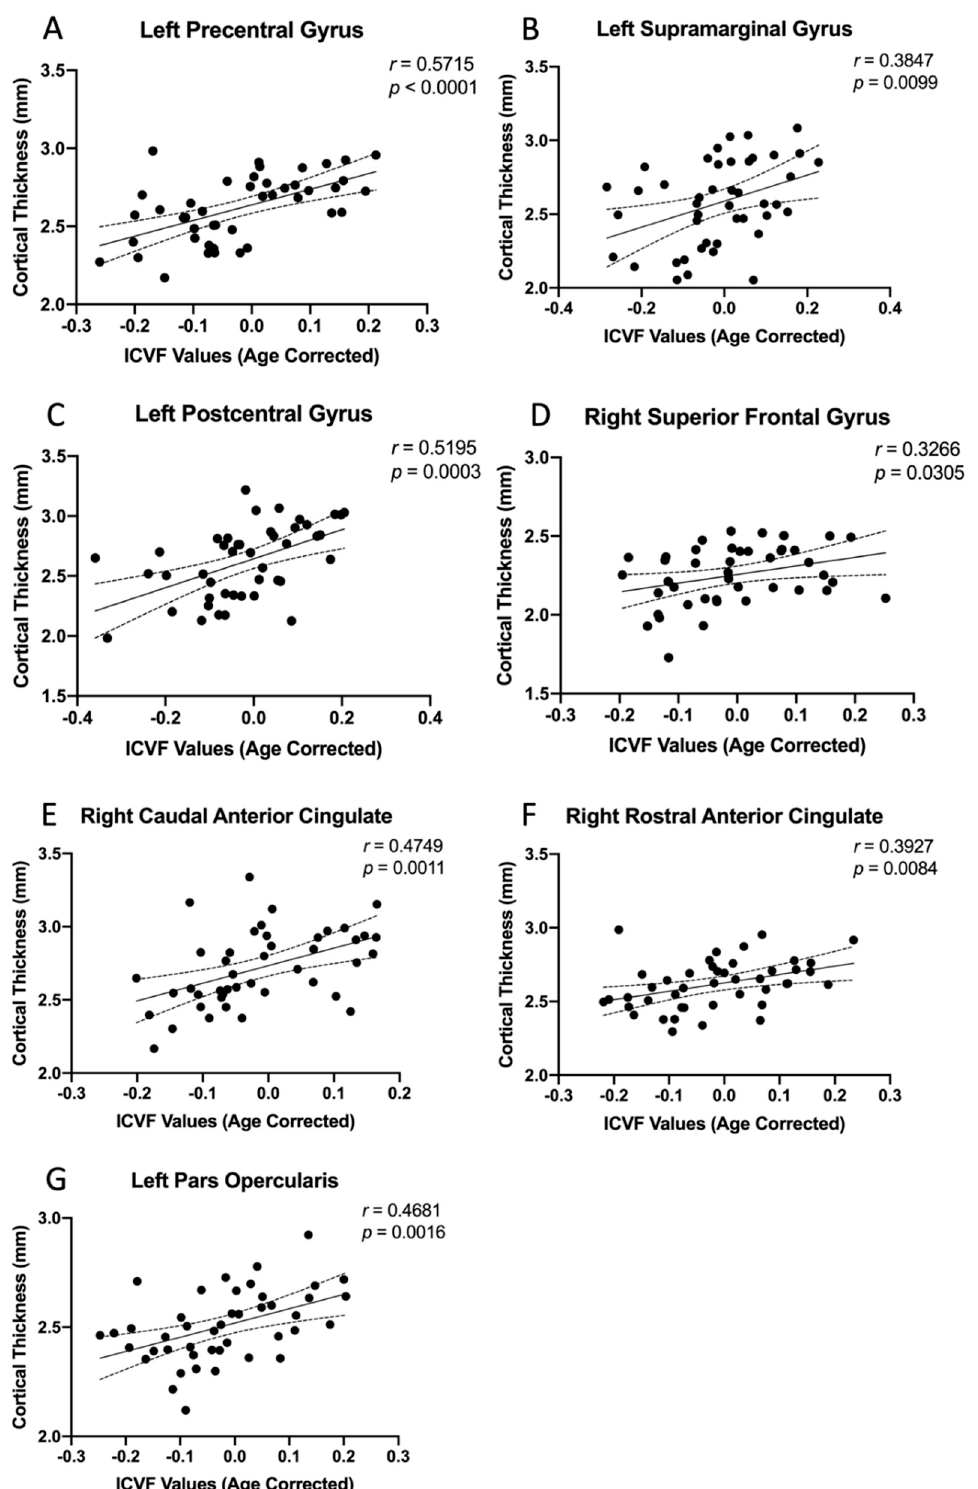
Figure 3. ( A ) The left precentral gyrus ( r = 0.5715, p < 0.0001), ( B ) the left supramarginal gyrus ( r = 0.3847, p = 0.0099), ( C ) the left postcentral gyrus ( r = 0.5195, p = 0.0003), ( D ) the right superior frontal gyrus ( r = 0.3266, p = 0.0305), ( E ) the right caudal anterior cingulate ( r = 0.4749, p = 0.0011), ( F ) the right rostral anterior cingulate ( r = 0.3927, p = 0.0084), and ( G ) the left pars opercularis ( r = 0.4681, p = 0.0016), showing significant correlations between ICVF values and cortical thickness across 44 subjects in the study patient cohort.